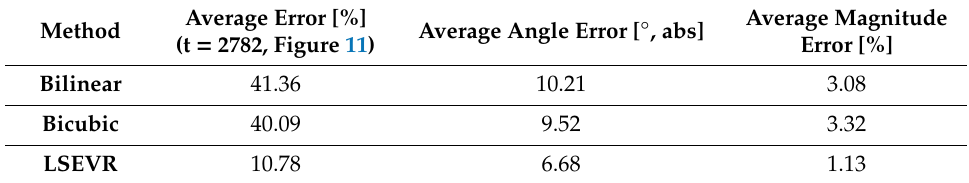
Table 4. Summary of accuracy of vector replacement techniques for clumped data for time shown and across set of 100 timesteps. Vector angle and magnitude error given for full set.